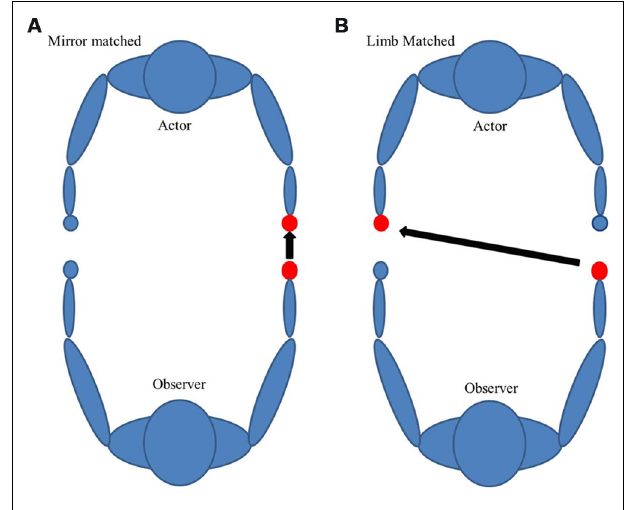
FIGURE 1 |There are two possible ways an action can be encoded from an allocentric perspective: (A) Mirror or (B) limb-matched. The following figure is an example for a dominant right-handed